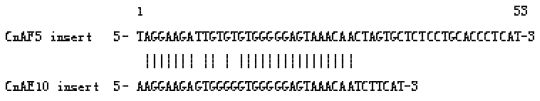
Alignment of the inserts in two clones obtained using primer A. Vertical lines indicate paired nucleotides.